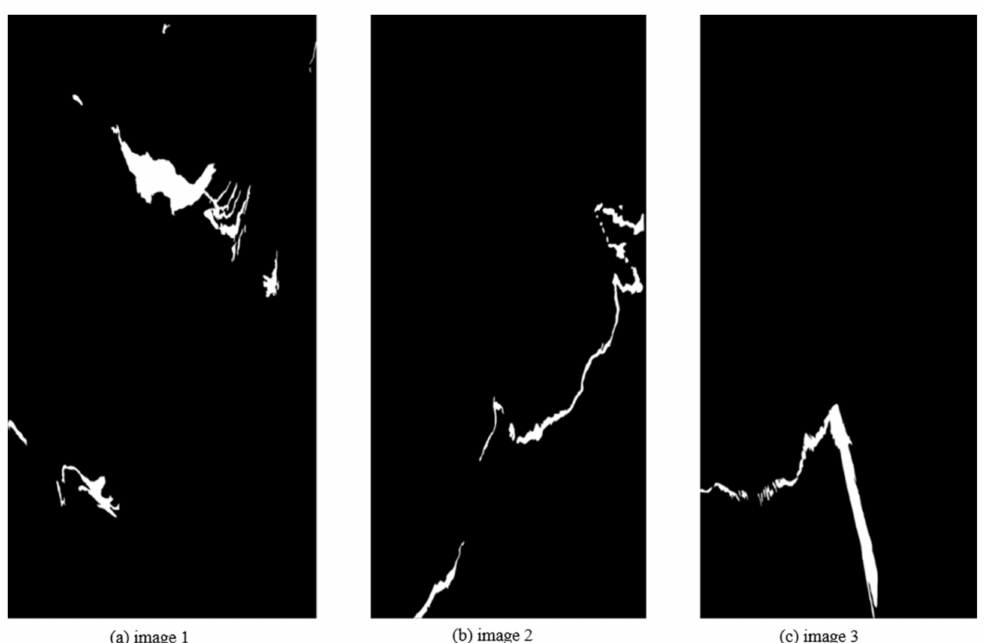
Figure 7. Oil spill pixels for the binary image are marked manually: ( a ) binary image of image 1; and ( b ) binary image of image 2; and ( c ) binary image of image 3. White represents oil spill pixels, while black represents non-oil spill